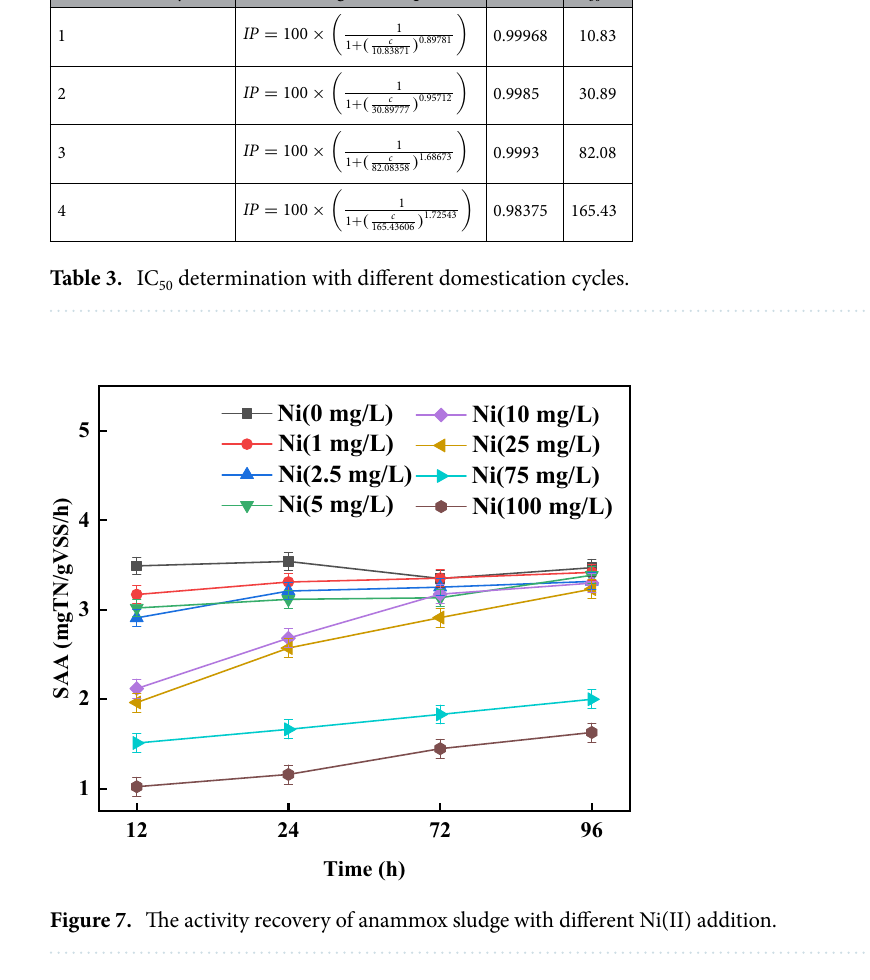
Ni(II) addition were about 303 mg-TN/g-VSS and 103 mg-TN/g-VSS, respectively. When Ni(II) addition was 25 mg/L, the TN cumulative removal after four times cycles obviously increased than that after three times cycles. When Ni(II) addition was 75 mg/L, there was no significant difference about TN cumulative removal between three times cycles and four times cycles. And, the TN cumulative removal with 75 mg/L Ni(II) addition was only 31.57% of that without Ni(II) addition. The inhibition of anammox microorganisms by Ni(II) addition was reduced after multiple cycles domestication with 25 mg/L Ni(II) addition. With a higher Ni(II) addition (75 mg/L), the inhibition did not eliminate well with multiple cycles domestication. The inhibition response to Ni(II) accumulated in the sludges with 25 mg/L Ni(II) addition was shown in Fig. 6b. The relation between the inhibition response and Ni(II) concentration of the anammox sludges with different times cycles were exponentially fitted by (Eq. 2). The fitting equations, fitting coefficient R 2 and IC 50 calculated by (Eq. 2) were summarized and listed in Table 3. The IC 50 values for one-, two-, three- and four- times cycles were 10.83, 30.89, 82.08, and 165.43 mg/L, respectively. The IC 50 values increased with a raise in the number of cycles. Therefore, with low Ni(II) concentration (≤ 25 mg/L) addition, anammox microorganisms can extend their tolerance to Ni(II) by multiple intermittent exposures to Ni(II). Recovery of anammox activity after Ni(II) shock. Recovery of anammox activity of the anammox sludges with different Ni(II) addition were presented in Fig. 7. The sludges exposed to different Ni(II) con- centration were washed by EDTA washing. When Ni(II) concentrations were 2.5, 5, 10, and 25 mg/L, the SAA recovered to 98.49%, 95.61%, 97.42%, and 93.25% of the SAA without Ni(II) addition. When Ni(II) concentra- tions were 75 and 100 mg/L, only 53.47% and 46.49% of the SAA without Ni(II) addition were gotten after EDTA washing, respectively. When Ni(II) concentration was no more than 25 mg/L, Ni(II) not in liquid most stayed outside of the sludges through extracellular adsorption (Fig. 5c). Little Ni(II) entered into the inside of the sludges with Ni(II) addition no more than 25 mg/L. The inhibition of anammox activity by Ni(II) with lower Ni(II) addition can be eliminated after EDTA washing. However, Ni(II) content of intracellular accumulation increased with a further raise of Ni(II) concentration. High Ni(II) concentration may lead to an irreversible deactivation of the anammox bacteria. Intracellular accumulation Ni(II) is not easy to clean by EDTA washing.